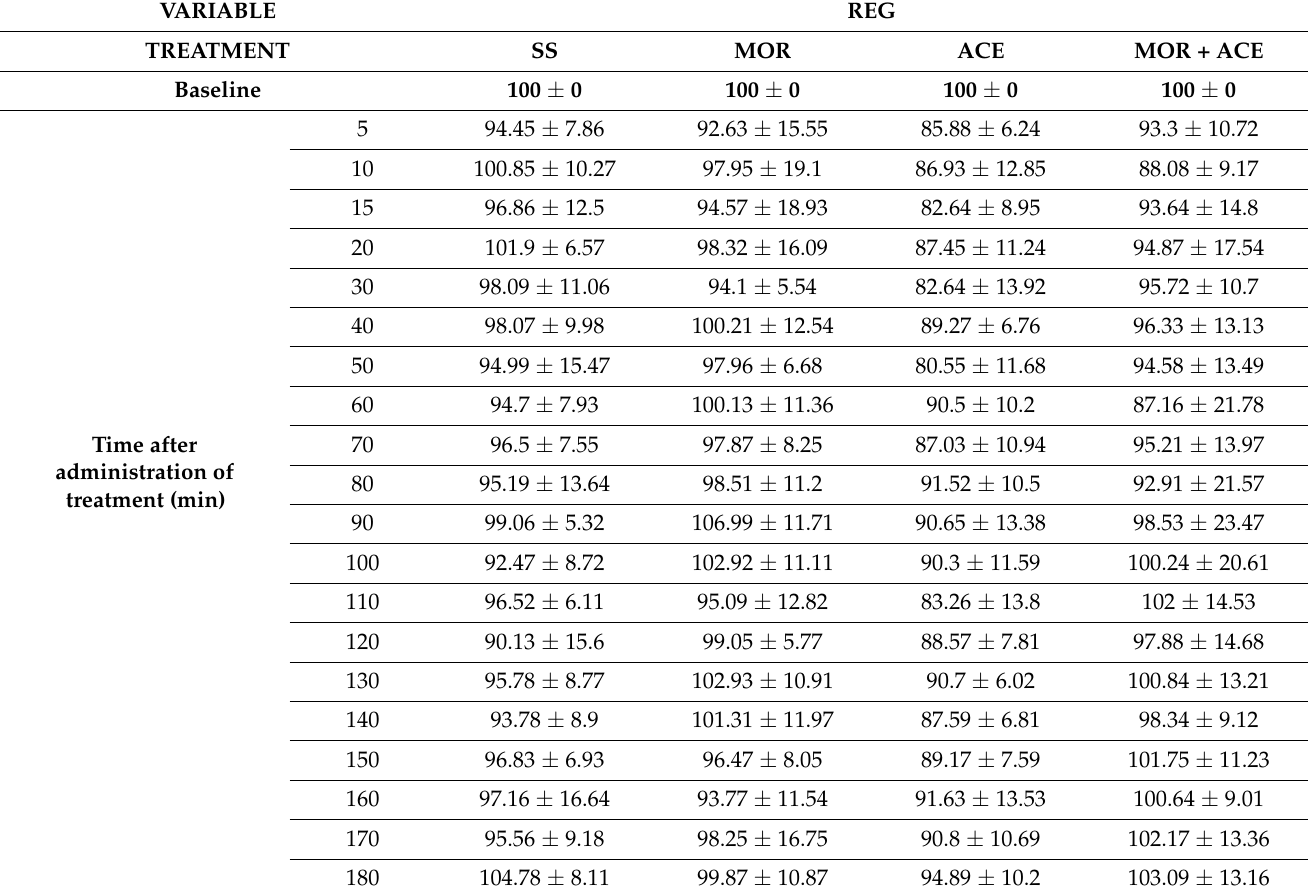
Table 2. Values at walk of coordination variable at − 10, 5, 10, 15, 20, and then every 10 min